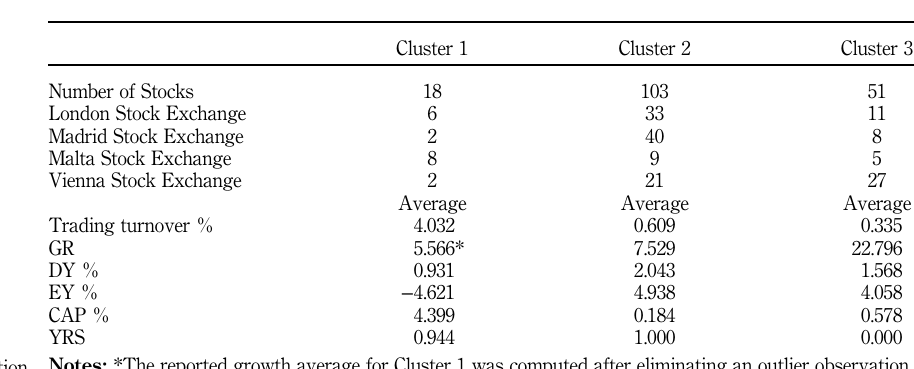
Table III. Summary information for the three